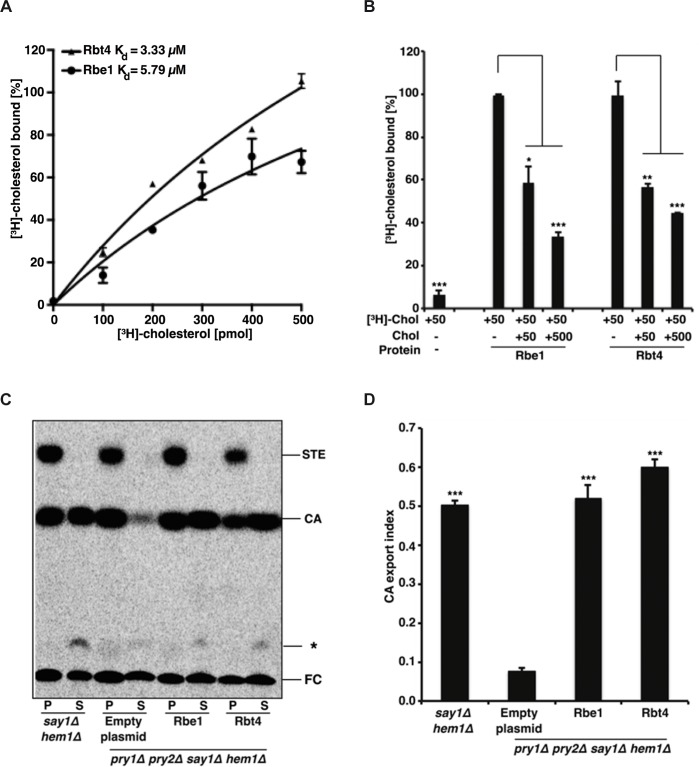
Rbe1p and Rbt4p bind cholesterol in vitro and rescue the sterol export defect of yeast cells lacking PRY1 and PRY2.(A) Purified Rbe1p and Rbt4p bind cholesterol in vitro. Sterol binding was assessed using increasing amounts of [3H]-cholesterol (100–500 pmol) and 100 pmol of purified protein. Unbound radioligand was separated from proteins, and the bound radioligand was quantified by scintillation counting. Data represent the mean ± SD of four independent experiments. (B) Cholesterol binding specificity of Rbe1p and Rbt4p was assessed using 100 pmol purified protein incubated with 50 pmol of [3H]-cholesterol in the presence of 50 pmol or 500 pmol unlabeled cholesterol. Competition results are plotted relative to the ligand binding of Rbe1p and Rbt4p. Data represent the mean ± SD of three independent experiments. Statistical significance of data was analyzed by a multiple t-test. Asterisks denote statistical significance (* P < 0.05; ** P < 0.001; *** P < 0.0001). (C) Expression of RBE1 or RBT4 complements the sterol export defect of S. cerevisiae cells lacking endogenous CAP proteins. pry1Δpry2Δsay1Δhem1Δ cells containing either an empty plasmid or a plasmid carrying RBE1 or RBT4 were radiolabeled with [14C]-cholesterol and the extracted lipids from the cell pellet (P) and the culture supernatant (S) were separated by thin-layer chromatography. The positions of free cholesterol (FC), cholesteryl acetate (CA) and steryl esters (STE) are indicated on the right. The asterisk marks the position of an unidentified cholesterol derivative. (D) Export index indicating the relative fraction (exported CA/total CA) of cholesteryl acetate that is exported by the corresponding mutant strains. Data represent the mean ± SD of two independent experiments. Statistical significance of data was analyzed by a multiple t-test. Asterisks denote statistical significance (* P < 0.05; ** P < 0.001; *** P < 0.0001).